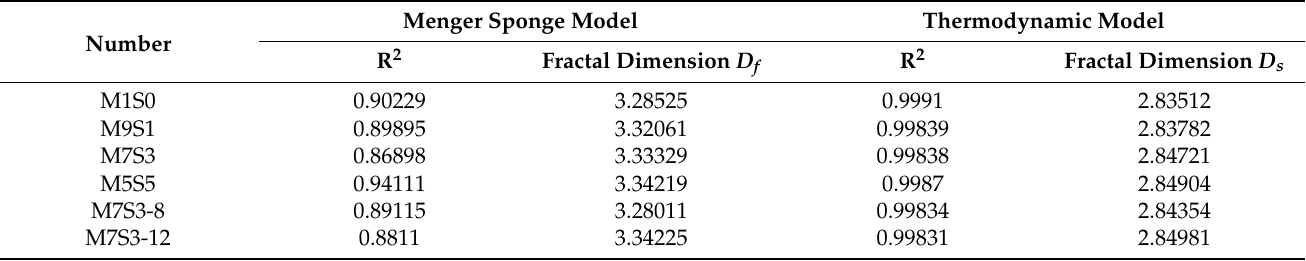
Table 6. Fractal dimension of AAMS composite cementitious